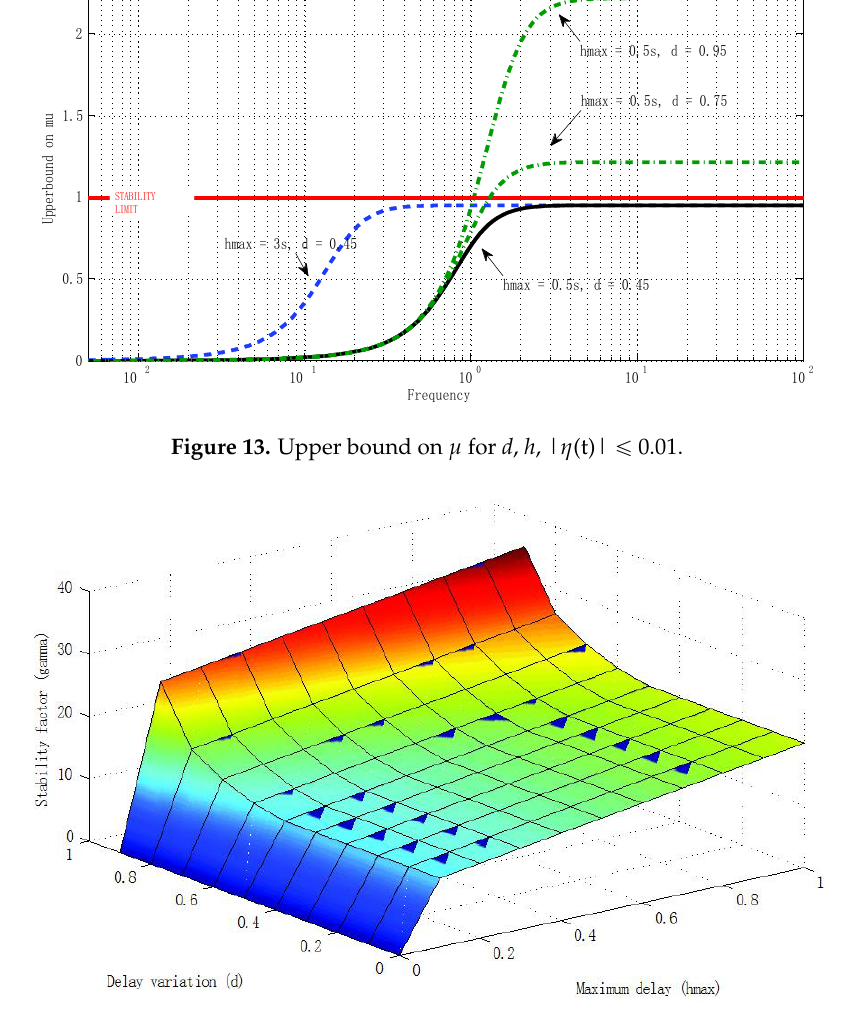
Figure 14. γ min ( z axis) needed to ensure stability given the delay bounds.